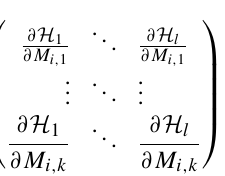
Figure 6. Innovation distributions over altitude for (a) horizontal reflectivity ( Z HH ), (b) differential reflectivity ( Z DR ), (c) specific differential phase ( K DP ) and (d) co-polar coefficient ( ρ HV ). N indicates the sample size for each DPOL variables.